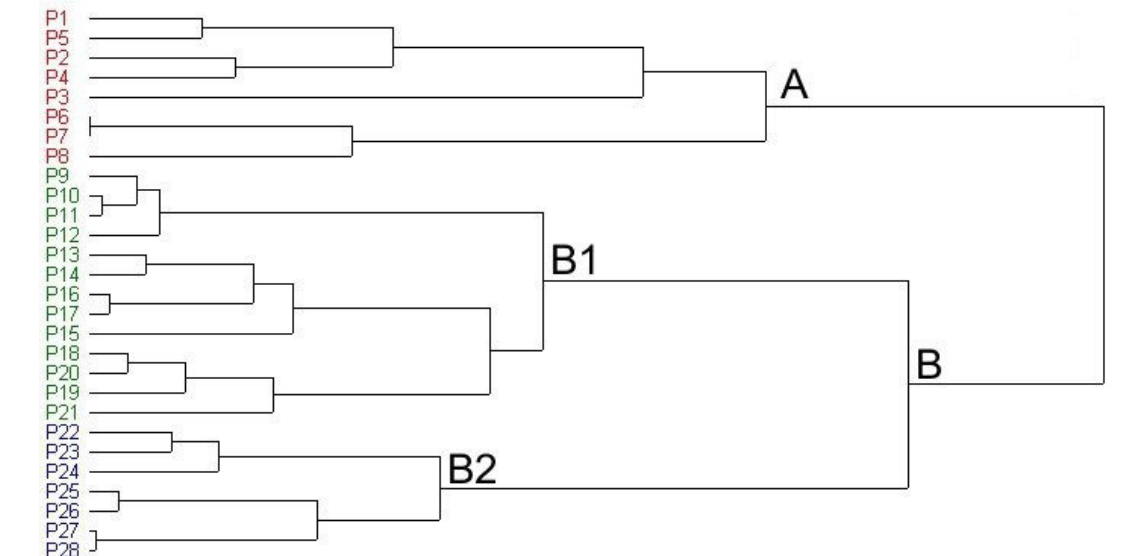
Figure 2. Dendrogram resulting from the cluster analysis. In red, group A; green, group B1; blue, group